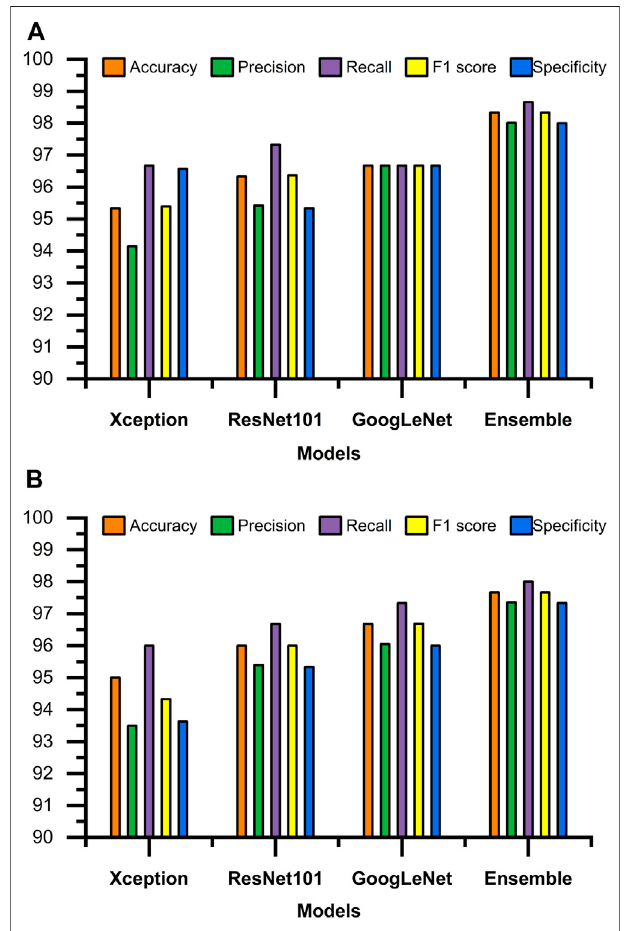
FIGURE 3 | Test results of all four classi fi ers for (A) informative frame detection and (B) cancerous and noncancerous polyp classi fi cation.